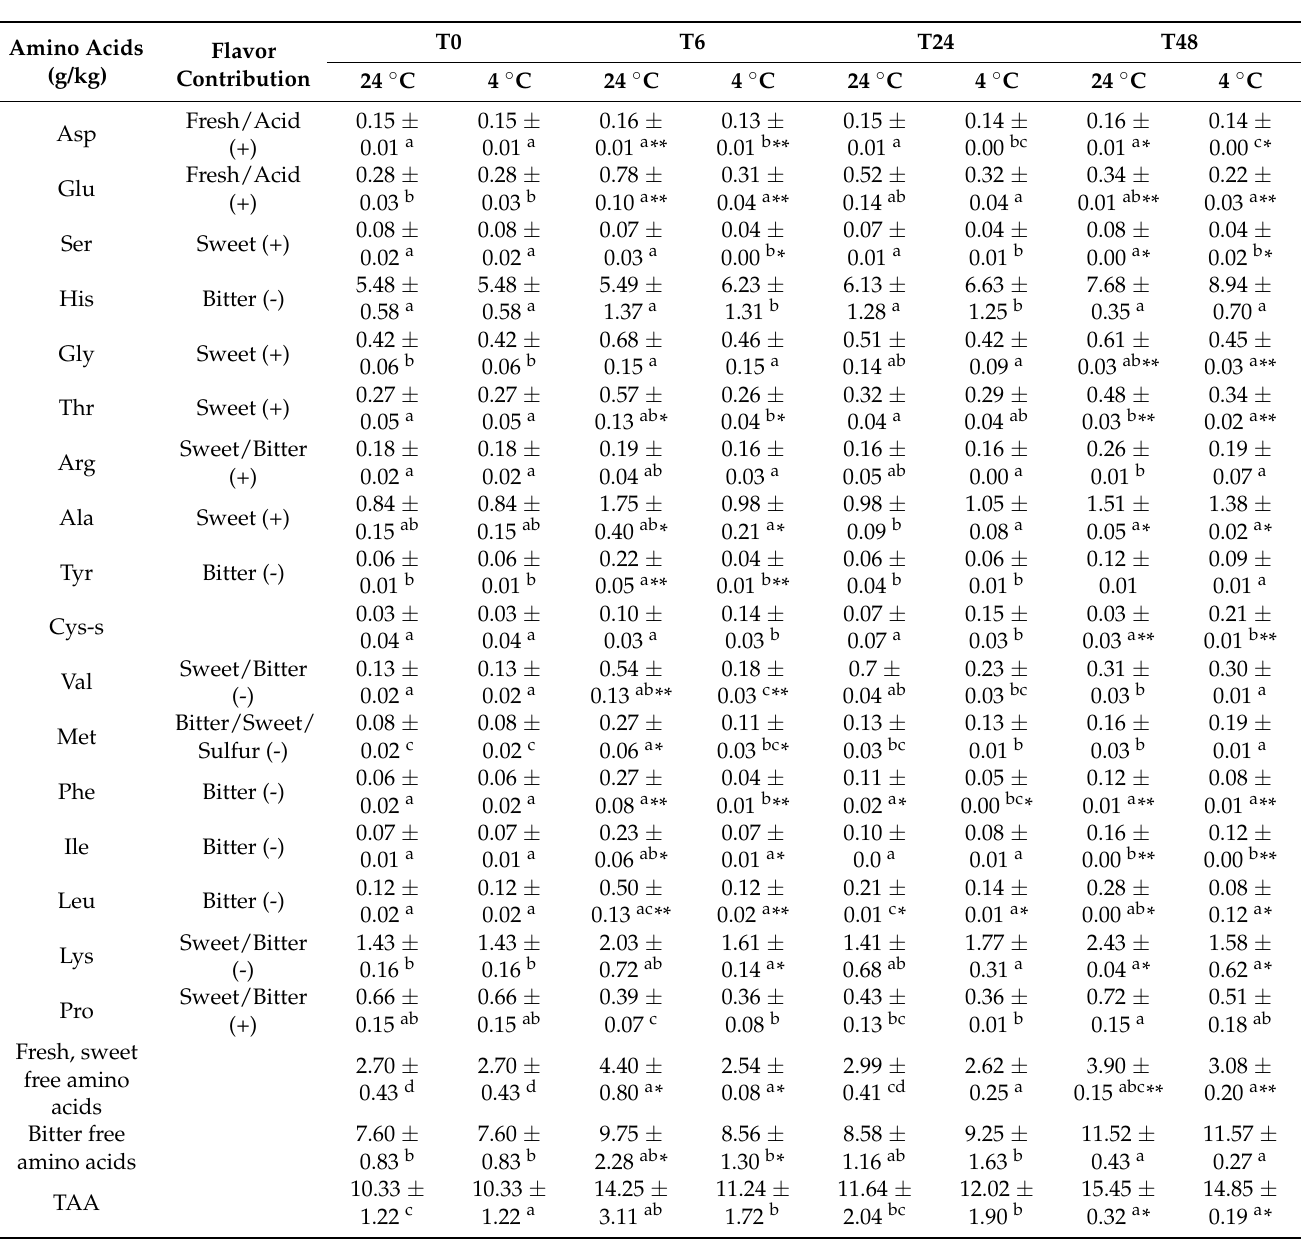
Table 8. Free amino acid content of American shad as storage progressed at 24 ◦ C (unrefrigerated) and 4 ◦ C